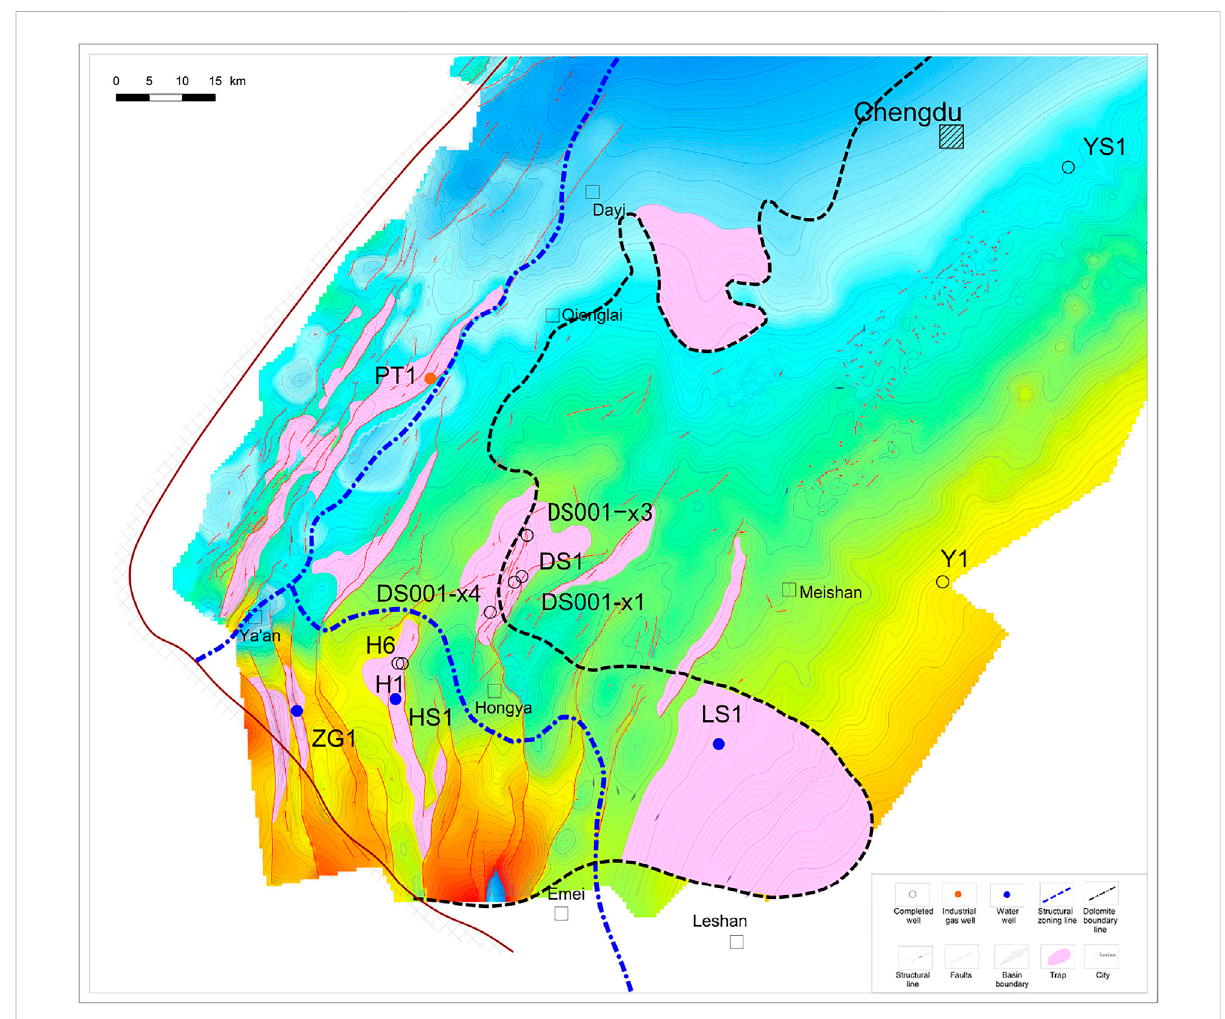
FIGURE 10 Structural zoning map of the Qixia Formation in the southwestern Sichuan